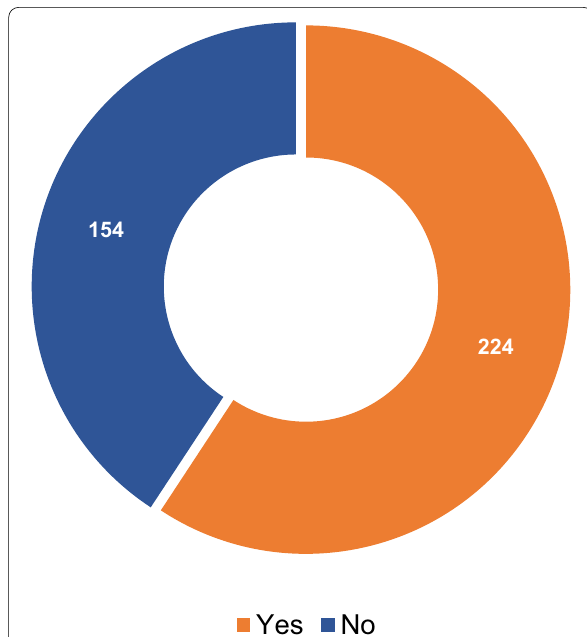
Fig. 7 Respondents who were supplied a copy of the radiology report from their examination